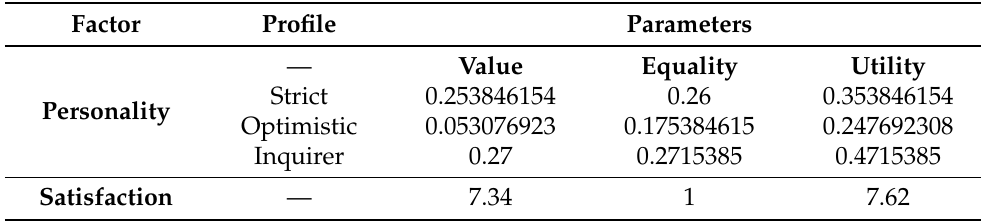
Table 23. Personality parameters corresponding to each decision profile.